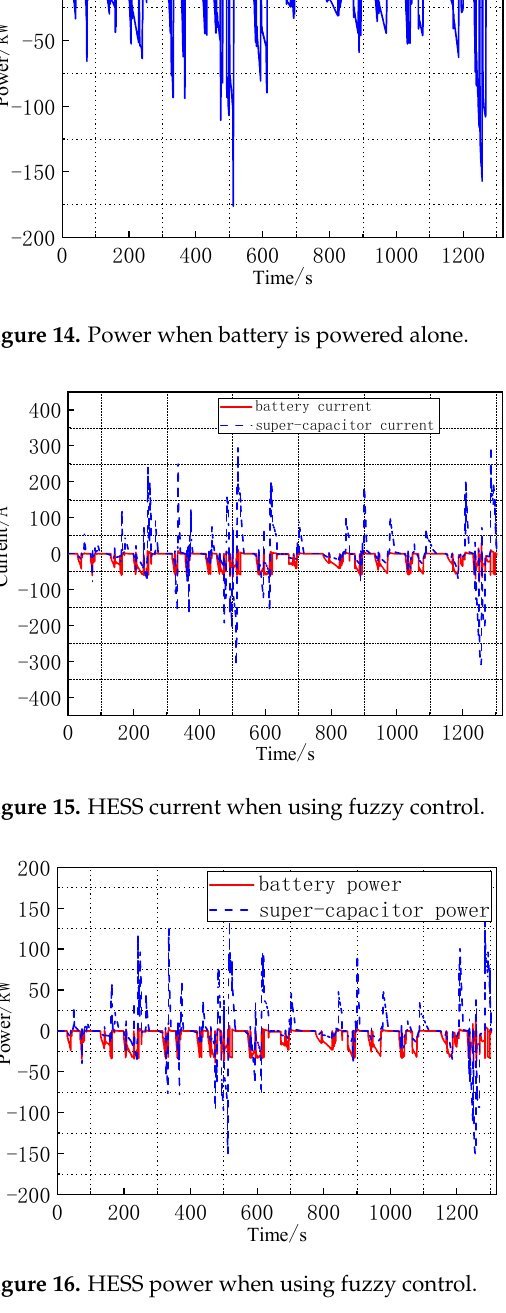
Figure 16. HESS power when using fuzzy control.